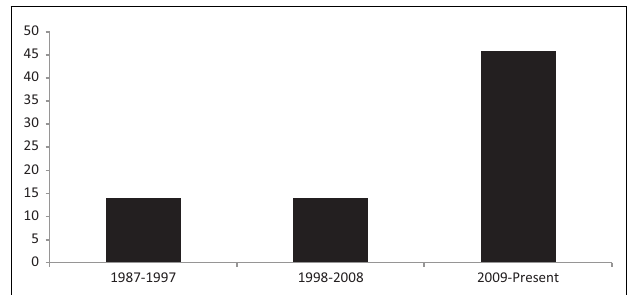
FIGURE 1 | Number of articles published in PubMed with the words “sleep” and “multiple sclerosis” in the title .